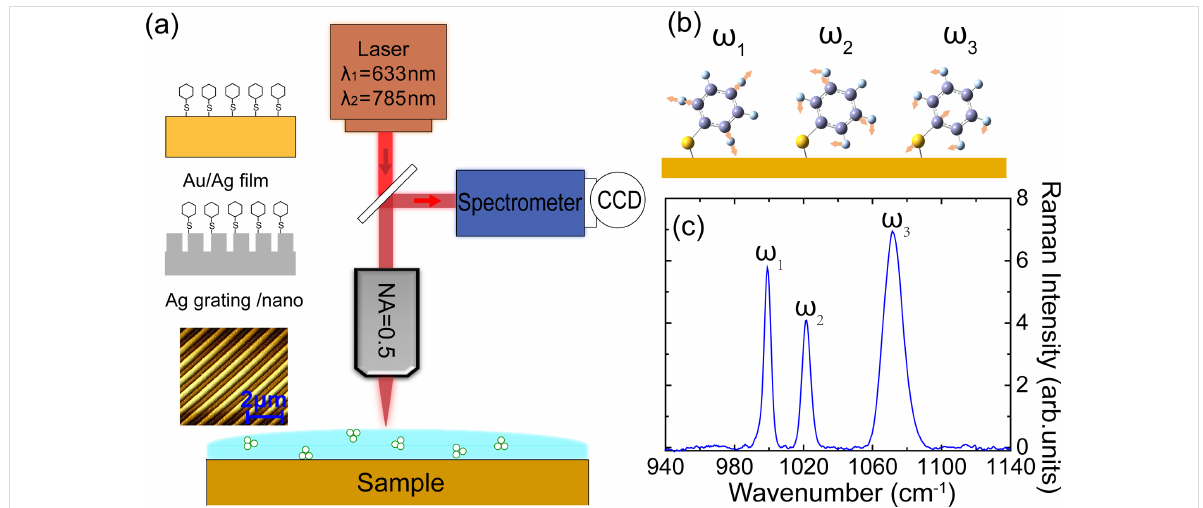
Figure 1: (a) Schematic of experimental arrangement and range of SERS substrates used with different enhancements. (b) Vibrational resonances of benzenethiol with nuclear motion as indicated and (c) corresponding SERS spectrum on a Ag nanosubstrate.